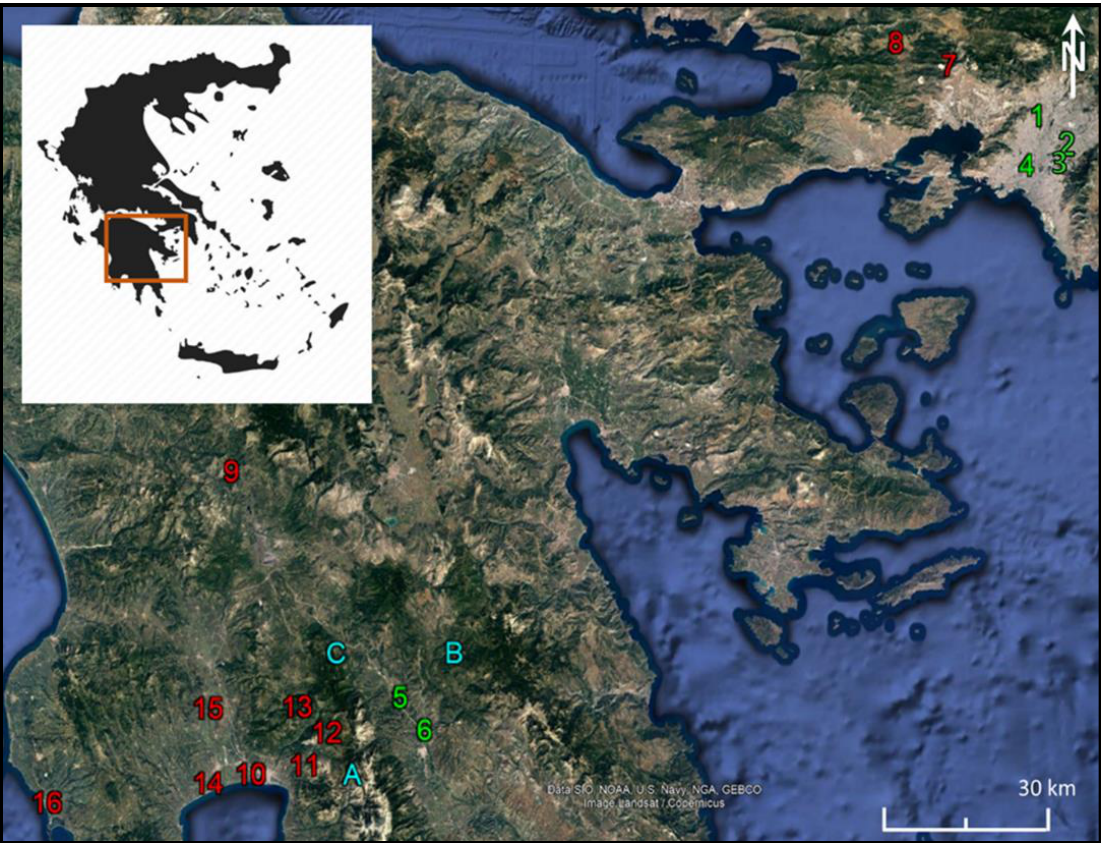
Figure 1. HYDRONET coverage in Attica-Boeotia and in the Peloponnese: in-house-built stations are indicated by green numbers, commercial stations by red numbers; blue letters indicate rain gauges. The numbers of the stations and the corresponding names are listed in Table 1.